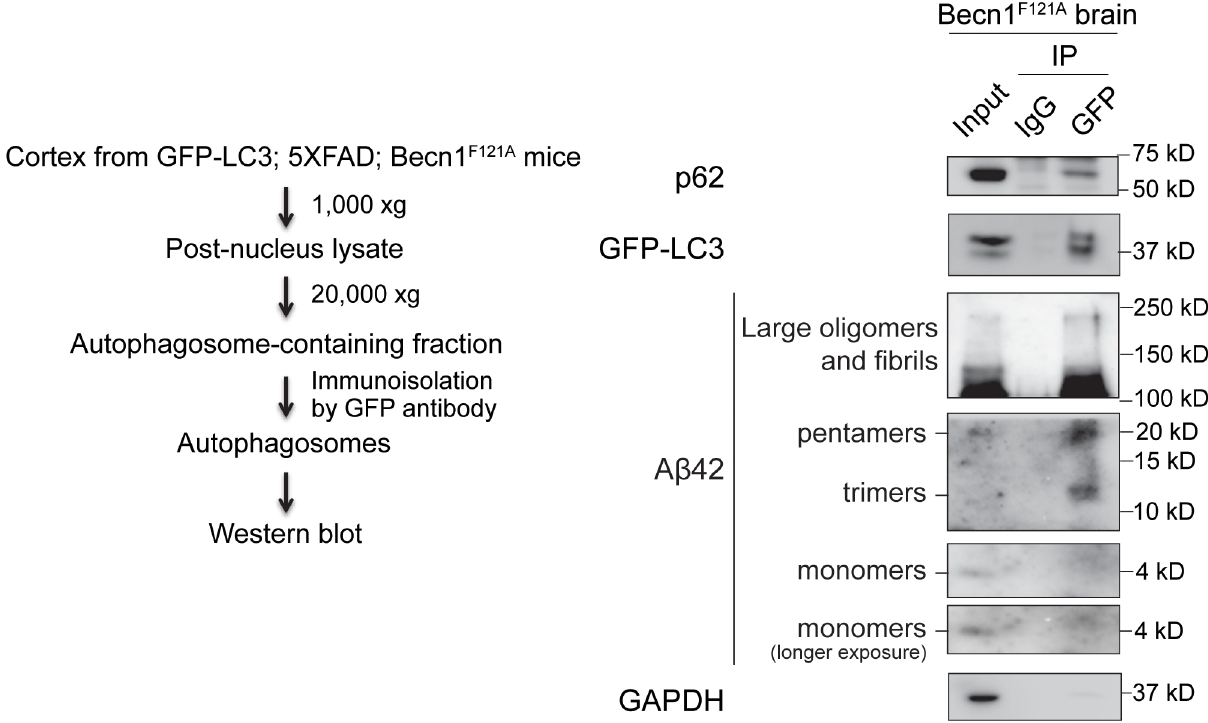
Fig 5. Autophagosomal sequestration of A β 42in brain of autophagy-hyperactive mice. (Left) Scheme of immunoisolation of autophagosomes from brain of 12-weekold 5XFAD Becn1 FA/FA mice expressingGFP-LC3. Briefly, post-nucleus extracts of the brain lysates was obtained by centrifugation at a low speedof 1,000 xg. Autophagosomes were enrichedby centrifugation at a high speed of 20,000xg, and pulleddown by an anti-GFP antibody using magneticbeads. (Right) Western blot detection of A β 42 fibrillar and oligomeric species insideautophagosomes immunoprecipitatedby GFP antibody as in the scheme. A known autophagycargo p62 serves as a positive control, and a cytosolic enzyme GAPDH is a negativecontrol.